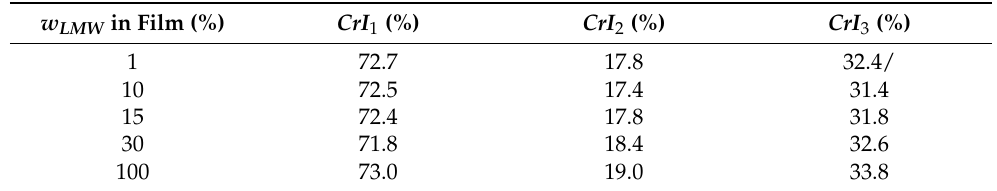
Table 2. Crystallinity indexes CrI 1 , CrI 2 , and CrI 3 obtained by different methods using X-ray diffraction patterns for chitosan films obtained with varied weight percentage of LMW chitosan w LMW in the precursor solutions. CrI 1 was obtained from Folcher et al. [58] CrI 2 and CrI 3 were obtained as previously reported by Osorio-Madrazo et al.